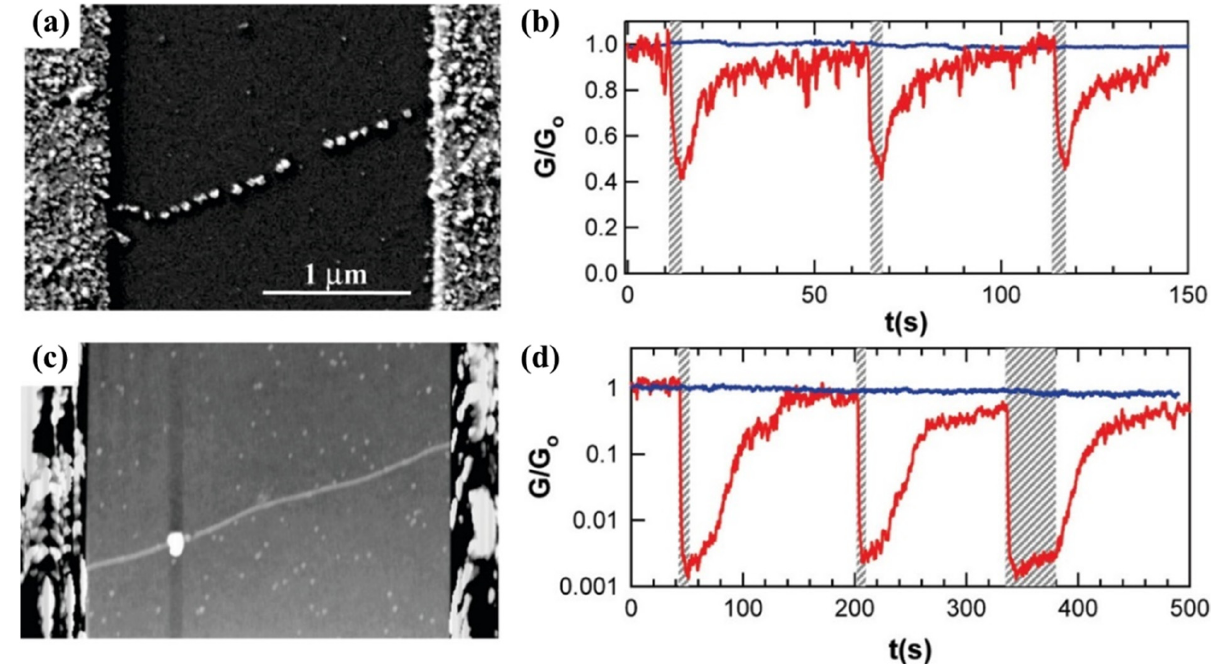
Figure 12. ( a ) SEM image of an s-SWCNT device with random Pd decorations all along its length. ( b ) Response of the device to pulses of H 2 in air, before (blue) and after (red) the Pd deposition. ( c ) Atomic force topography image of a second SWCNT with a production of a point defect and the selective decoration of these sites with Pd. ( d ) Response of the device with a point defect, before (blue) and after (red) Pd deposition, showing the nearly thousand-fold better response. Reprinted with permission from Ref. [142]. Copyright 2010, American Chemical